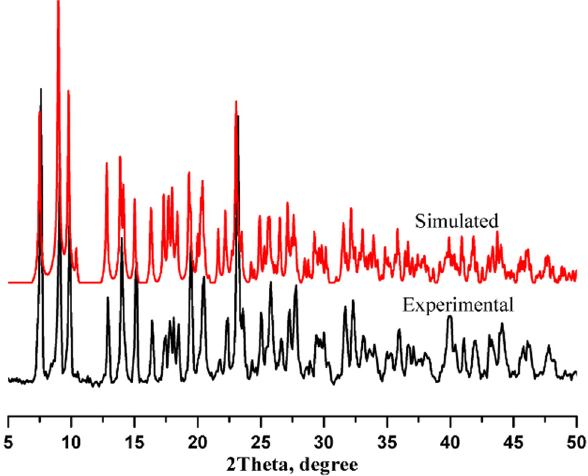
Figure 6: Powder X - ray di ff raction patterns of 1